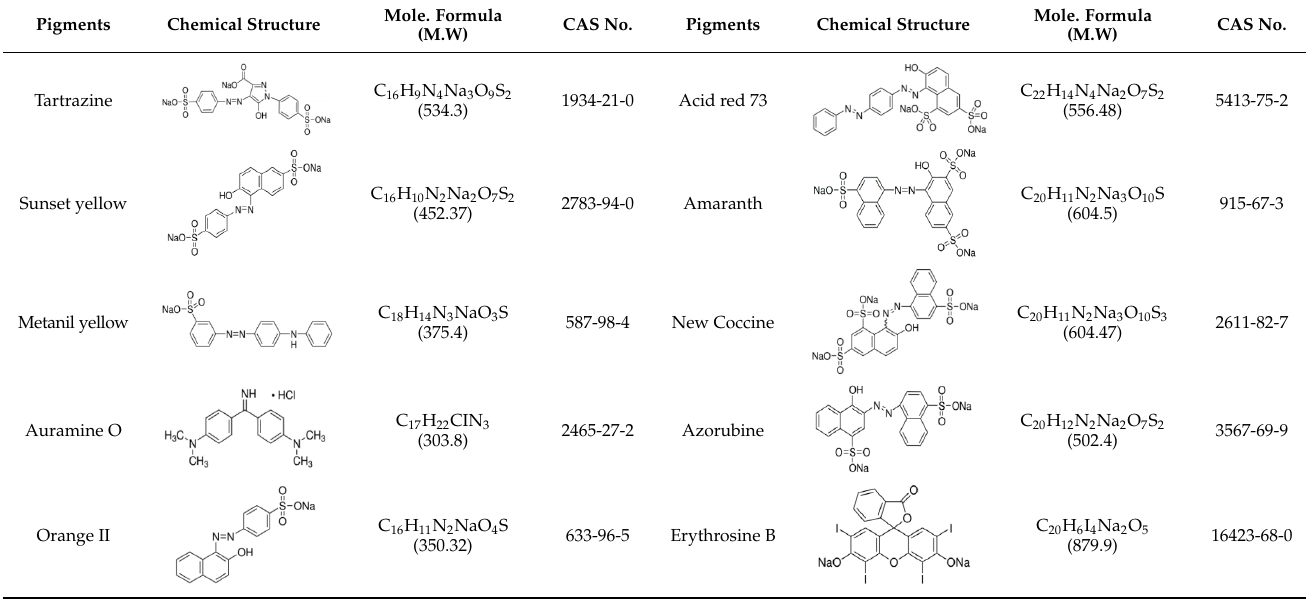
Table 1. Chemical structures, molecule weights, and formulas of ten synthetic pigment compounds.